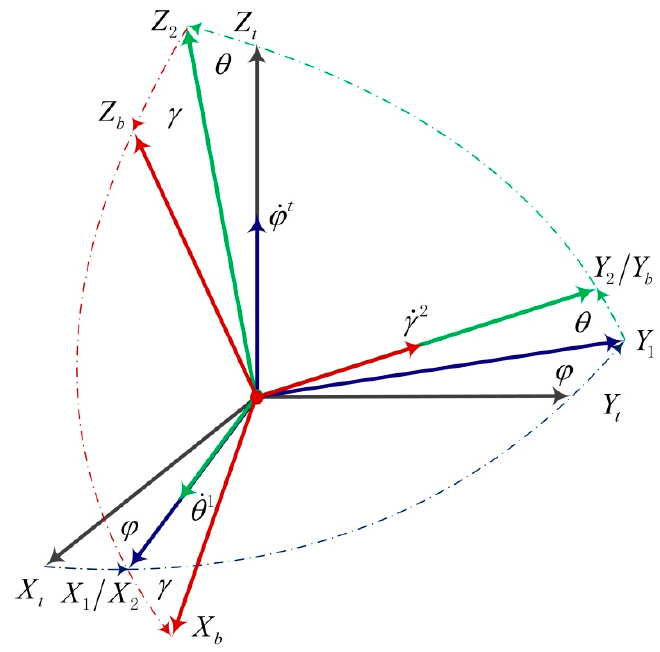
Figure 2. The Euler angles transformation relation for SINS.